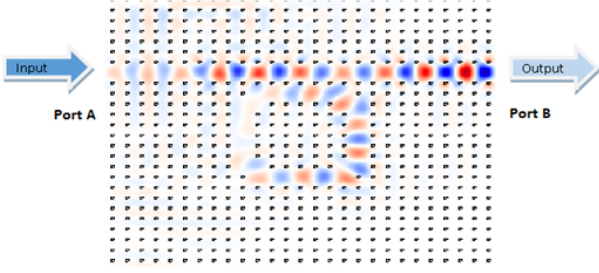
Figure 3. Design of the two-dimensional PhC line defect. Table 1. Different types of sensors and target substances for detec-